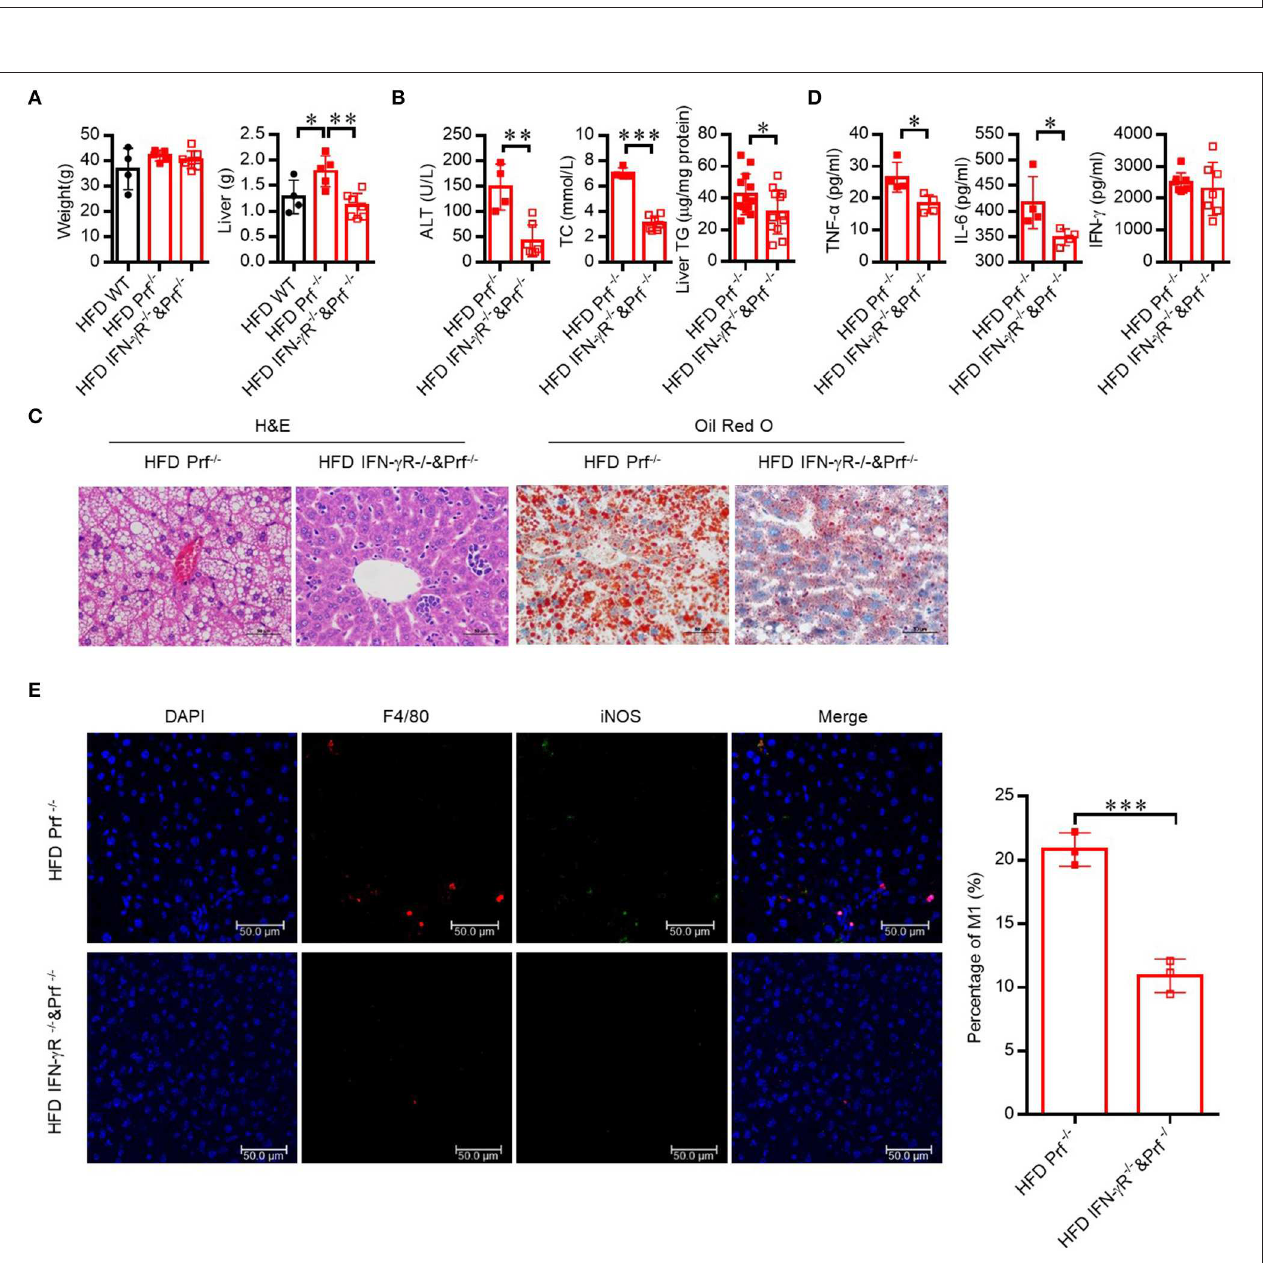
FIGURE 5 | Representative images of liver sections stained with H&E (top) and Oil red O (bottom). (D) Serum TNF- α and IFN- γ levels were determined ( n = 4–6). (E) Representative immunofluorescence images from liver with DAPI (blue), F4/80 (red), iNOS (green), and co-localization (merged image) (left) and the percentage of M1/M (refers to iNOS + F4/80 + cells/F4/80 + cells) was calculated (right). (F) Expression levels of lipogenic genes (left) and fatty acid oxidation genes (right) in the liver relative to Hprt expression levels ( n = 6–11). The data shown in each panel of the figures were collected from a single experiment, and each experiment was repeated for at least three times and rendered consistent results. Means ± SEM, * p < 0.05; ** p < 0.01, *** p < 0.001.